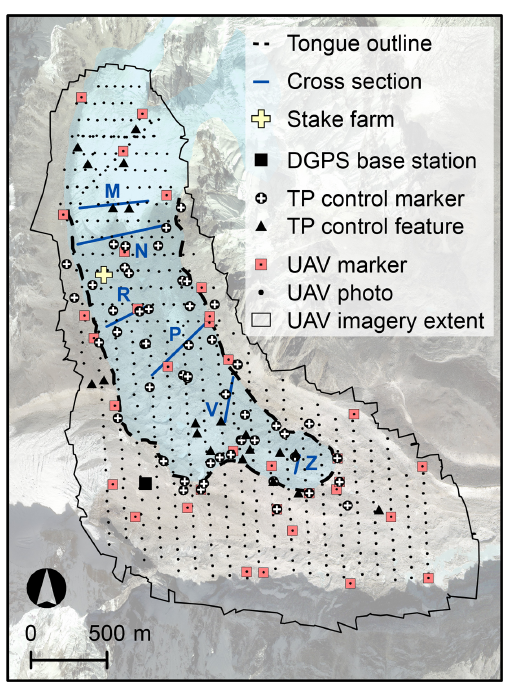
Figure 2. Map of debris-covered Changri Nup Glacier showing the glacierized area (light blue), DGPS cross sections (blue), delineated debris-covered tongue (dashed black line) and UAV imagery ex- tent (black line). TP is terrestrial photogrammetry and background is from ESRI basemap imagery. TP control markers are painted crosses, and TP control features are characteristic